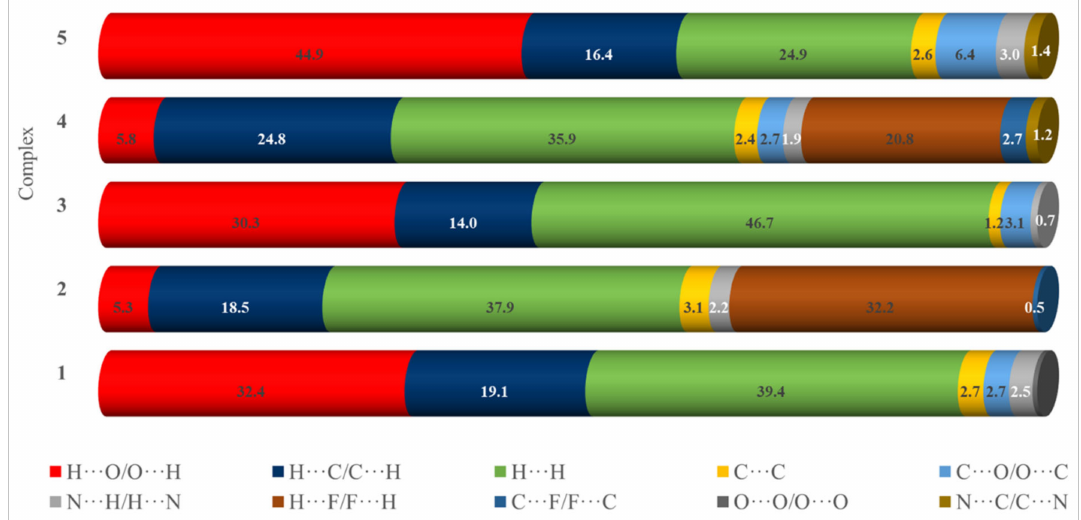
Figure 6. The percentage of non-covalent interactions for the analysed complexes extracted from 2D fingerprint